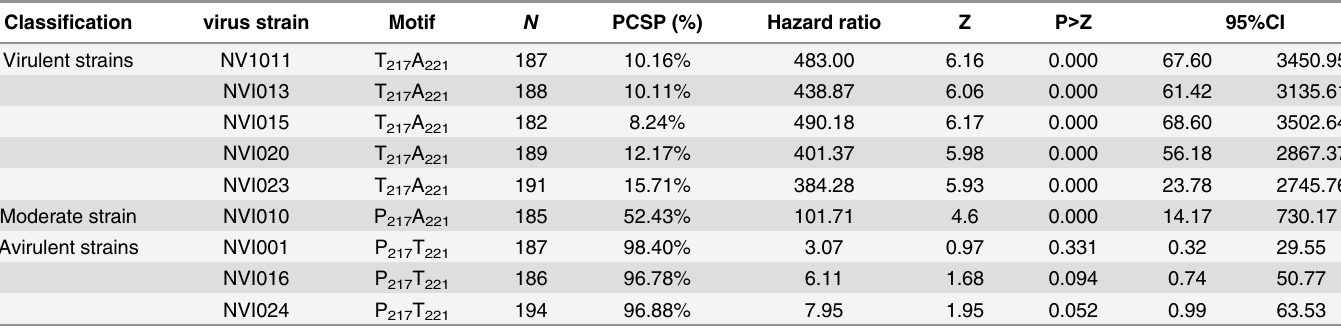
PCSP = Post challenge survival proportions; Virus strain = NVI designate Norwegian Veterinary Institute while the digits represent the isolate reference number; Motif = deduced amino acid positions linked to virulence on amino acid position 217 and 221 the VP2 capsid of IPNV; N = number of fi sh challenged for each virus strain; PCSP = post challenge survival proportion